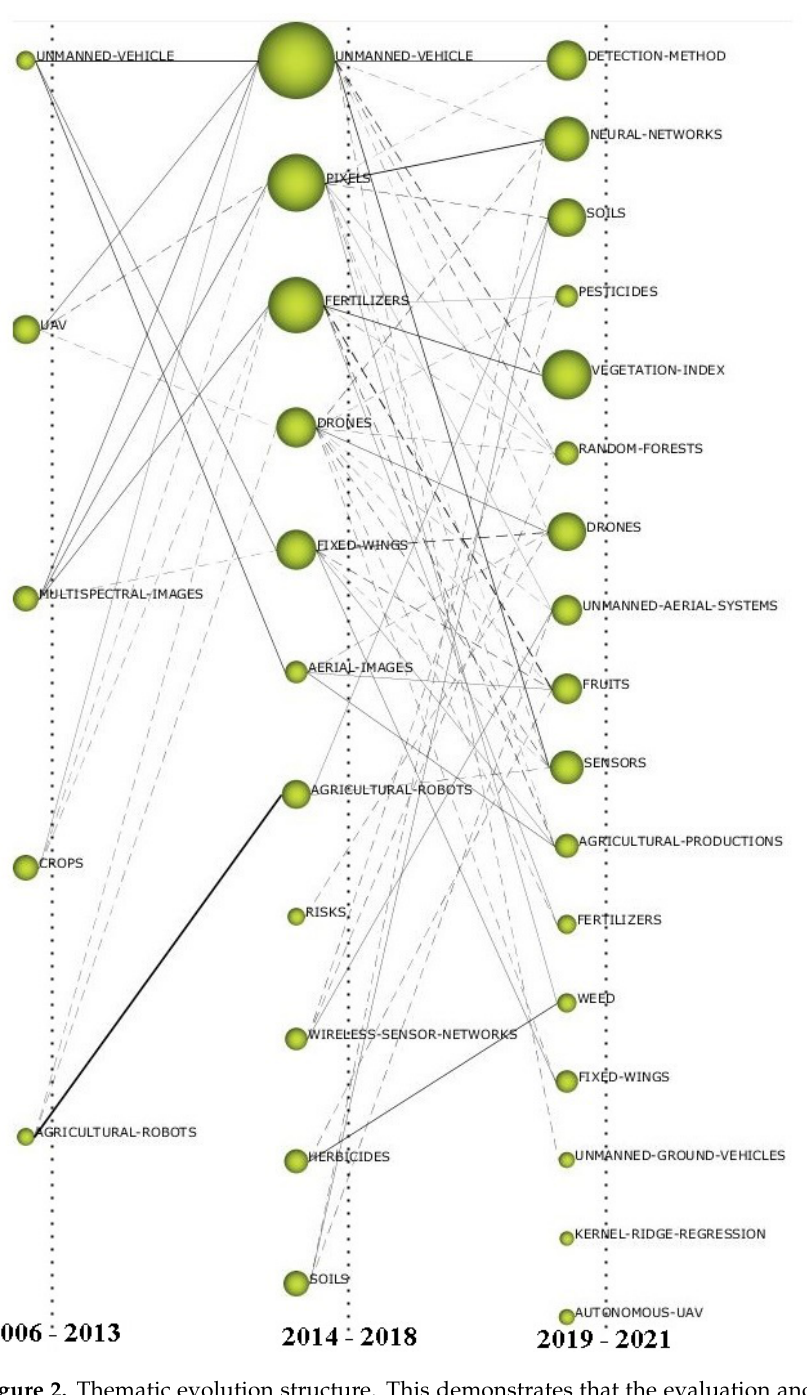
Figure 2. Thematic evolution structure. This demonstrates that the evaluation and association of keywords increased from 5 to 17 between 2006 and